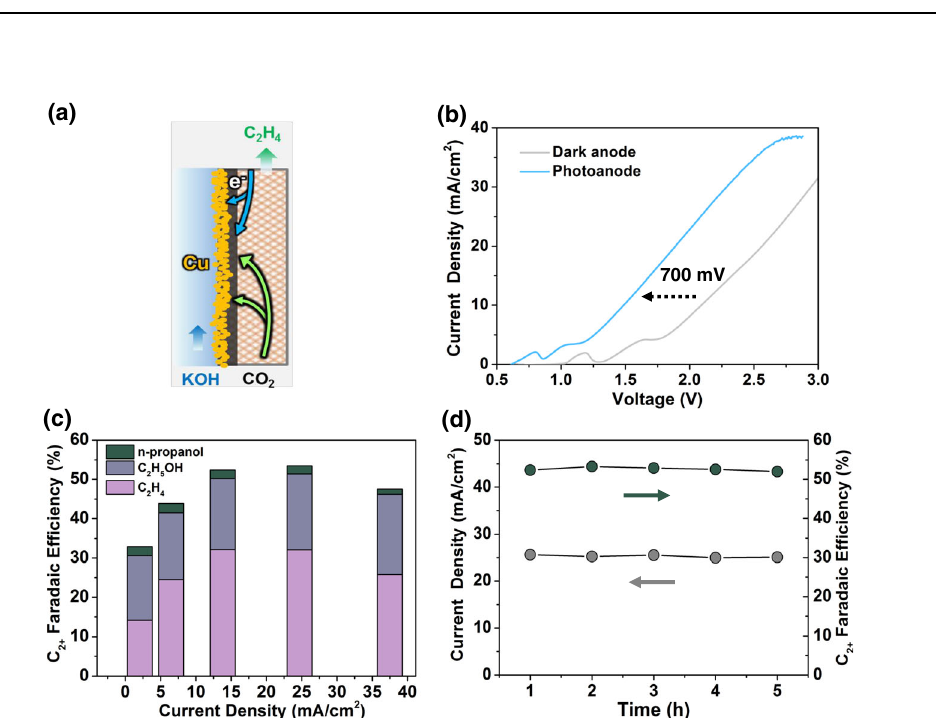
Fig. 4 | Performance of CO 2 to C 2+ with Si photoanode assistance. a The sche- maticofCucathode. b The J – V curvesofCO 2 RRwithandwithoutSiphotoanodein a two-electrode con fi guration. c The FE of C 2+ at different potentials.